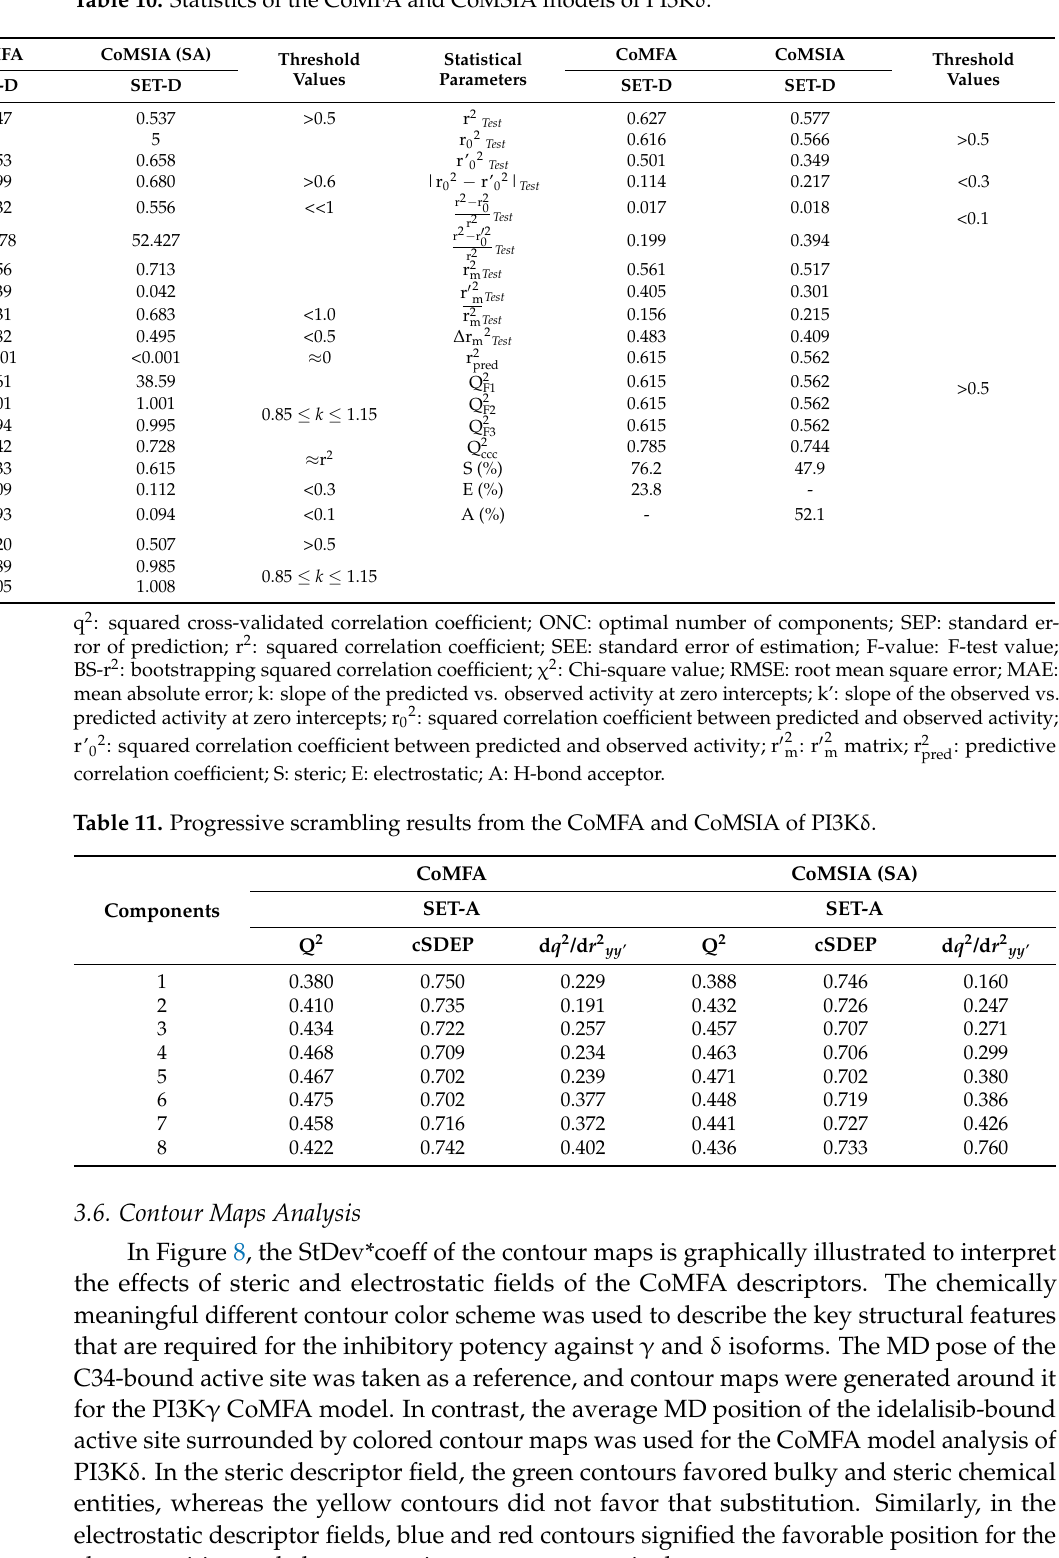
Table 10. Statistics of the CoMFA and CoMSIA models of PI3K δ .